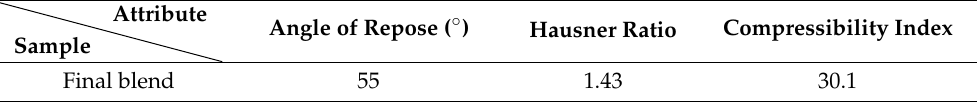
Table 2. Properties of the final blend.